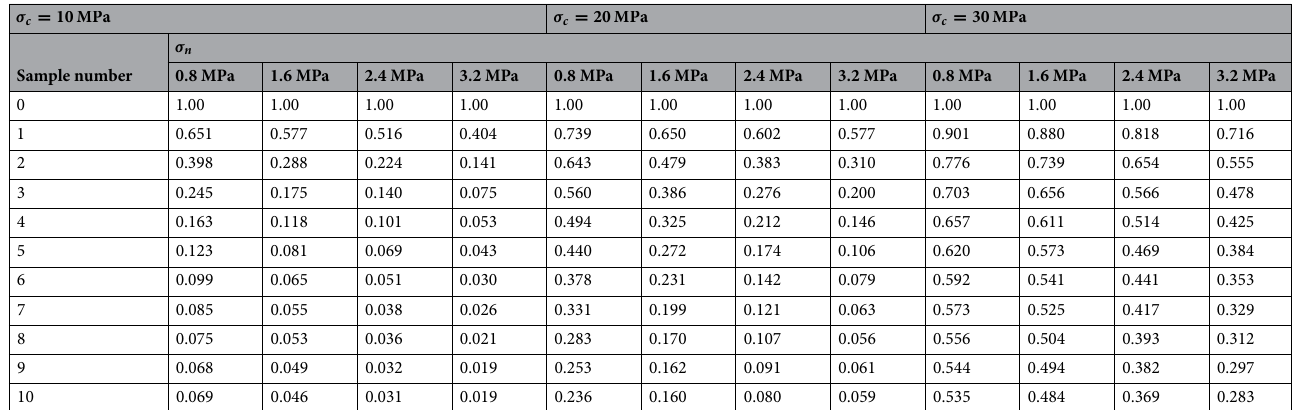
Table 3. Test results of R s for joint surface sample with initial asperity angle of 16° 36